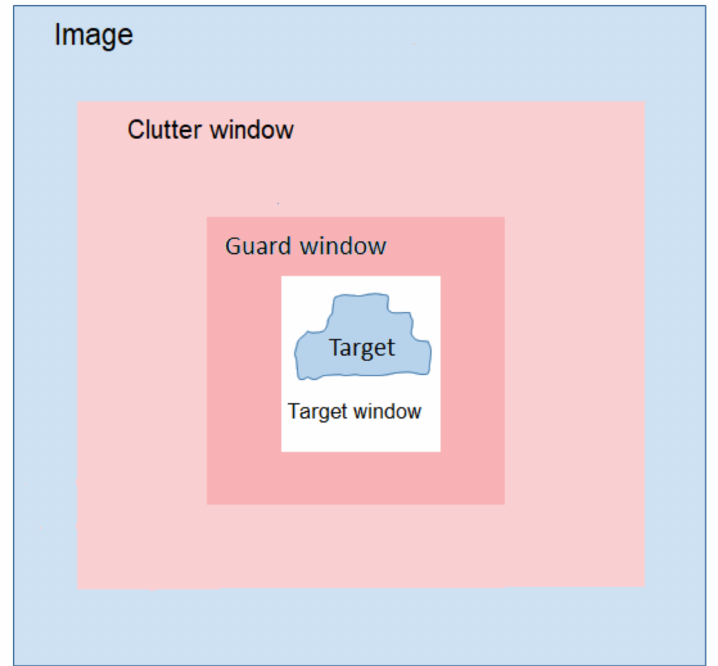
Figure 7. The guard window approach. The blue area represents image pixels, the light pink area represents the clutter window, and the dark pink area represents the guard window, to elimi- nate background clutter from the target window (white). In the case of this analysis, the target is an